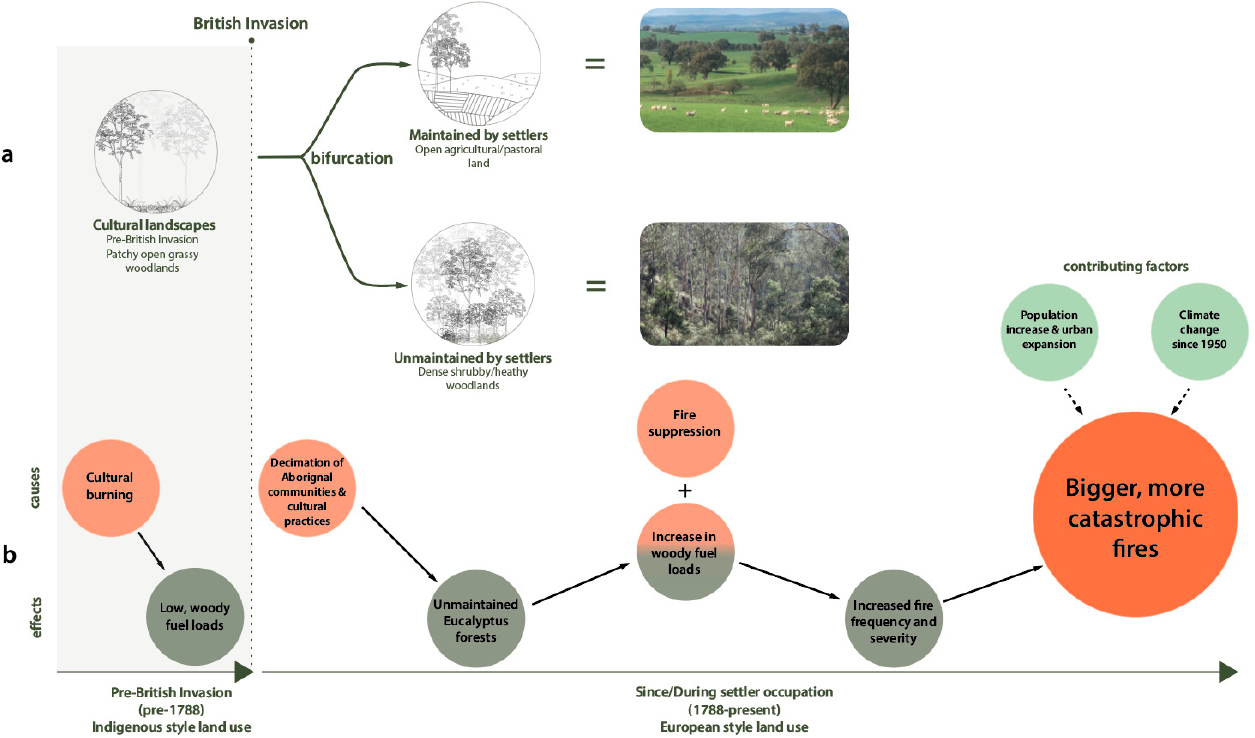
Figure 3. ( a ) Diagram of the bifurcation of the Southeast Australian vegetation landscape following the British Invasion where landscapes have divided into: (1) areas maintained by settlers as open pastoral or agricultural land and; (2) areas unmaintained by settlers becoming shrub-rich, dense woodlands [13]; ( b ) simplified process diagram demonstrating the pre-British Invasion, when under Indigenous land management current open landscapes (i.e., agricultural/pastoral land) were already dominated by grassy/herbaceous vegetation, and since the British Invasion, areas outside European-style land use (e.g., unmanaged Eucalyptus forests) have become shrub-dense, which in turn, has directly fueled an increase in the frequency and intensity of fires with other contributing factors (e.g., climate change and population/urban growth).